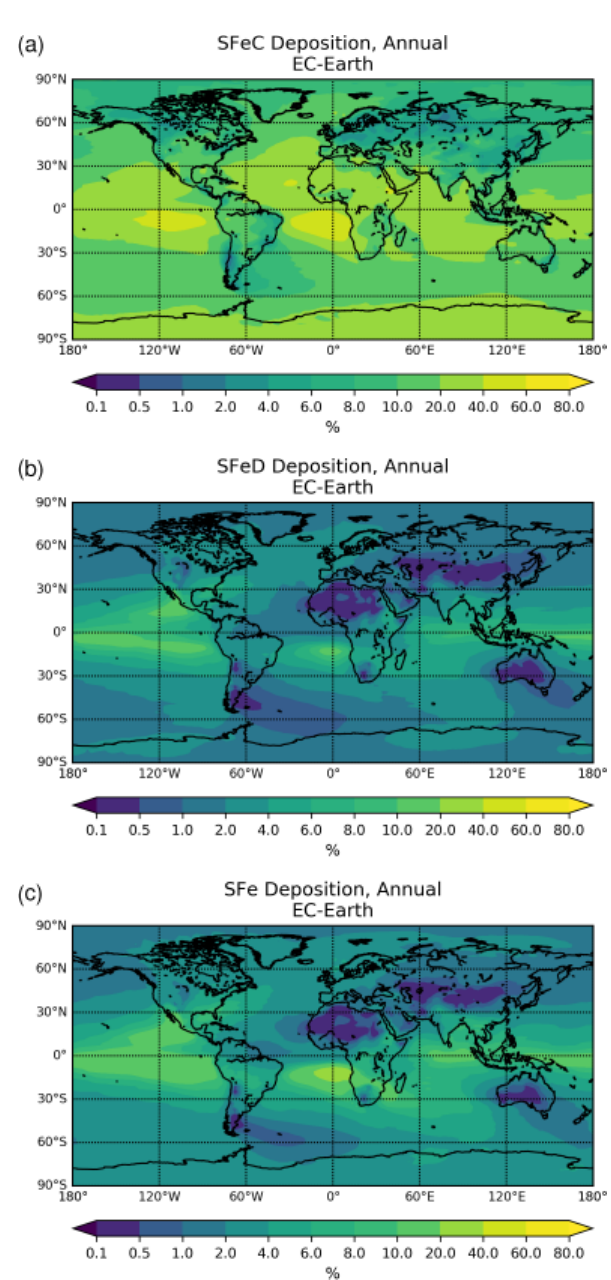
Figure 11. Annual mean Fe-containing aerosol solubility at depo- sition fluxes (%) as simulated for the EC-Earth simulation averaged for the period 2000–2014 for (a) mineral dust aerosols; (b) the sum of solid fuel combustion, liquid fuel combustion, and open biomass burning aerosols; and (c) the sum of all aerosol sources.